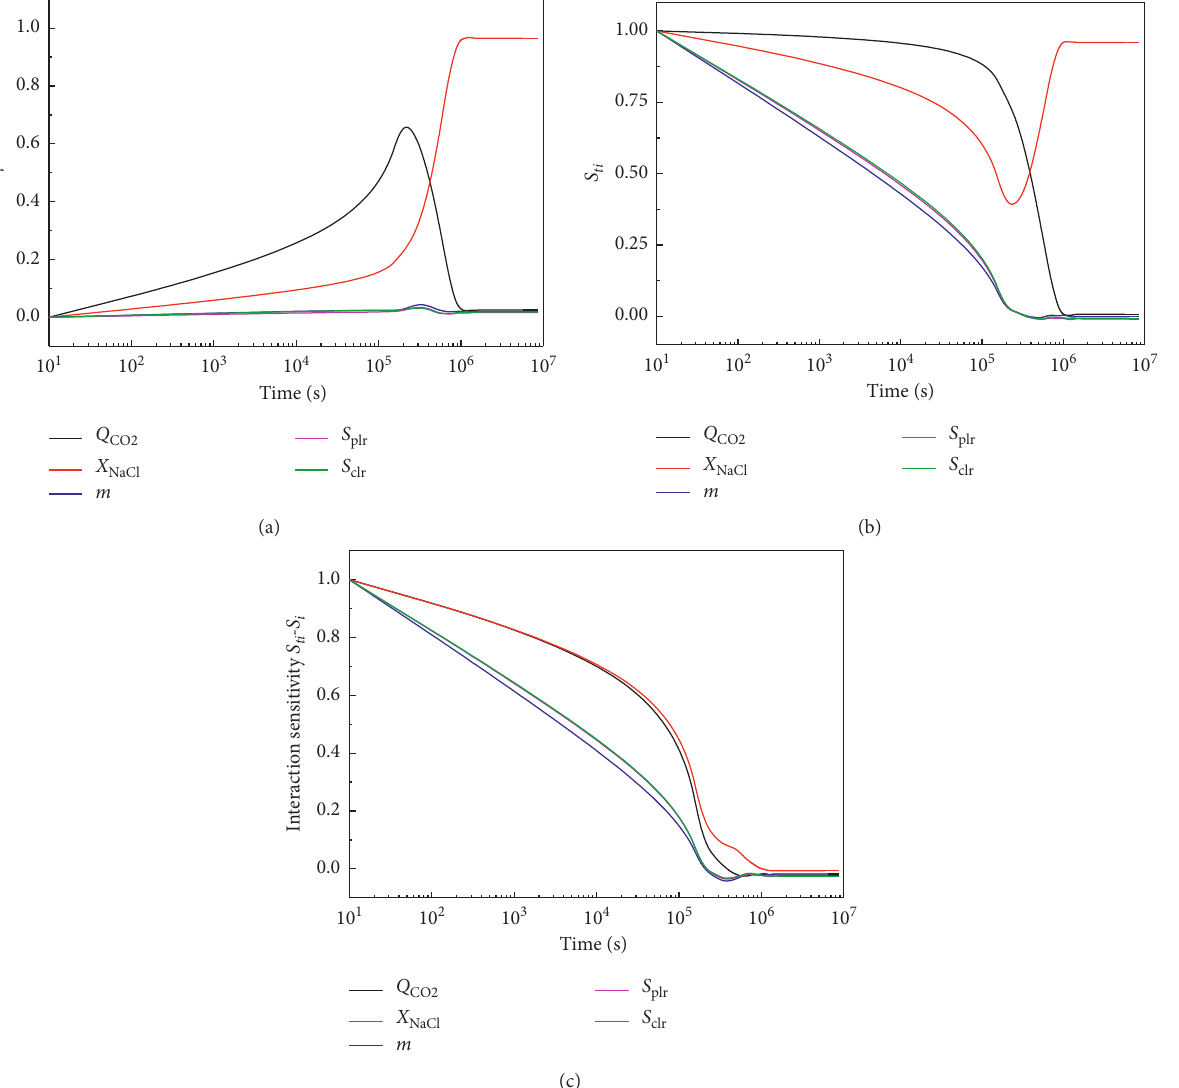
i ; (b) S ti ; (c) S ti - S i